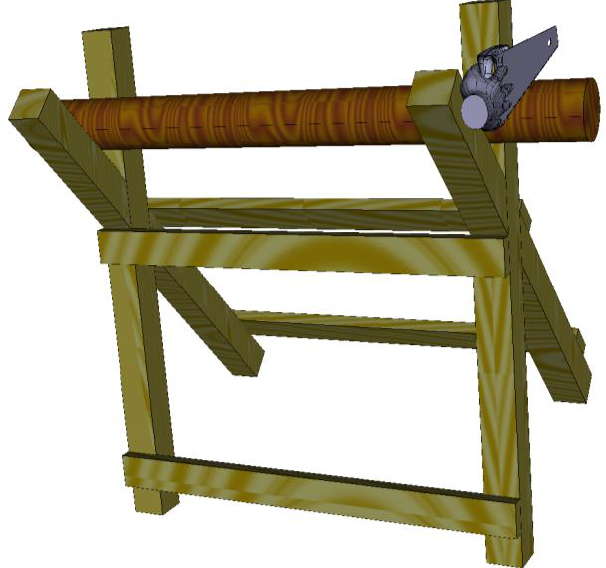
Figure 16. Visualization in real time on a computer display of the simulation of the cutting operation with the saw in the virtual environment.